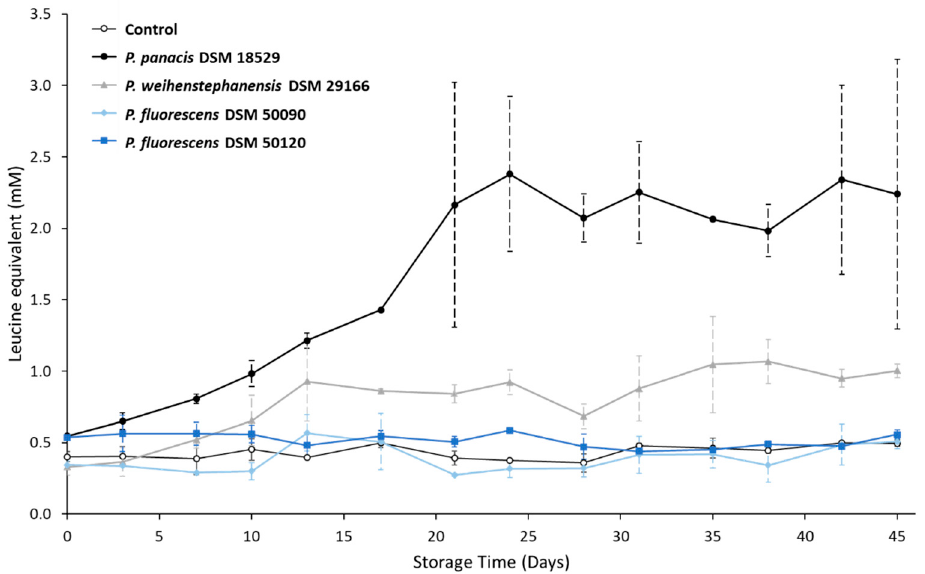
Figure 3. Development in levels of proteolysis assessed as level of free N-terminals in UHT milk inoculated with extracellular extracts, as well as the control, as a measure of proteolytic spoilage potential of the four Pseudomonas strains during storage for 45 days at 20 °C. Analysis performed on milk aliquots taken from the top of the milk bottles. The measurements were carried out from biological replicates (n = 2) and with technical replicates (n = 3).